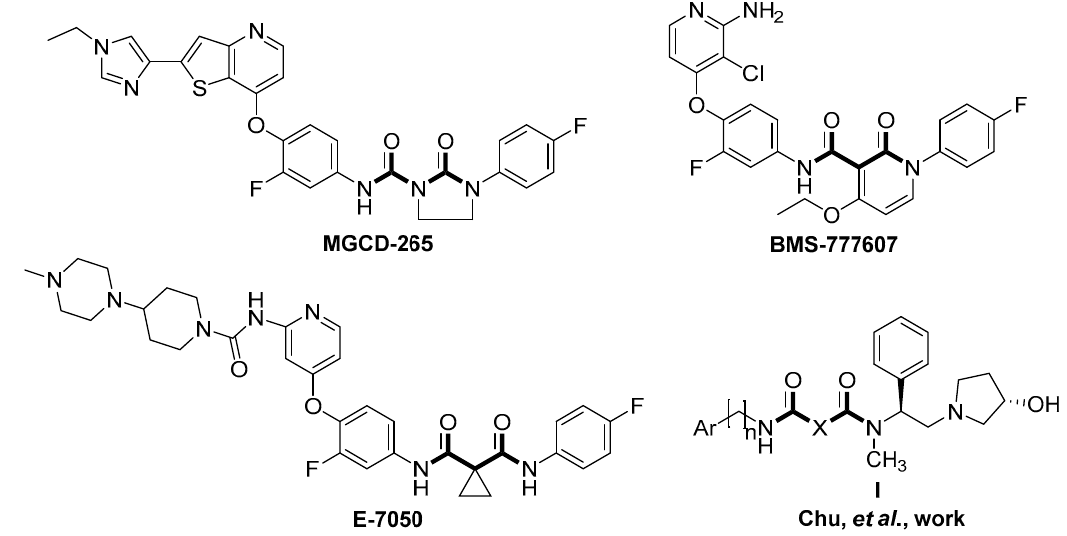
Figure 1. Structures of some biologically active N , N ′ -malonamide derivatives.